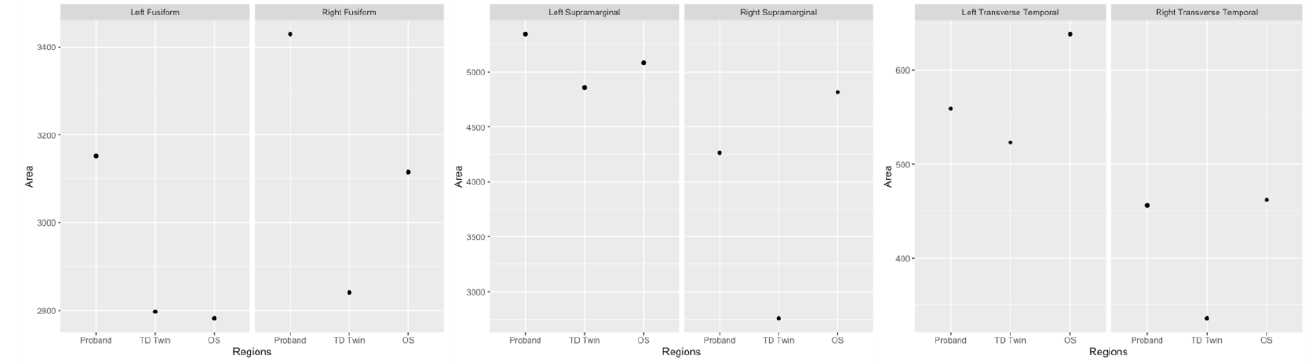
Figure 5. Plots of cortical surface area in the fusiform gyrus, supramarginal gyrus, and transverse temporal gyrus.